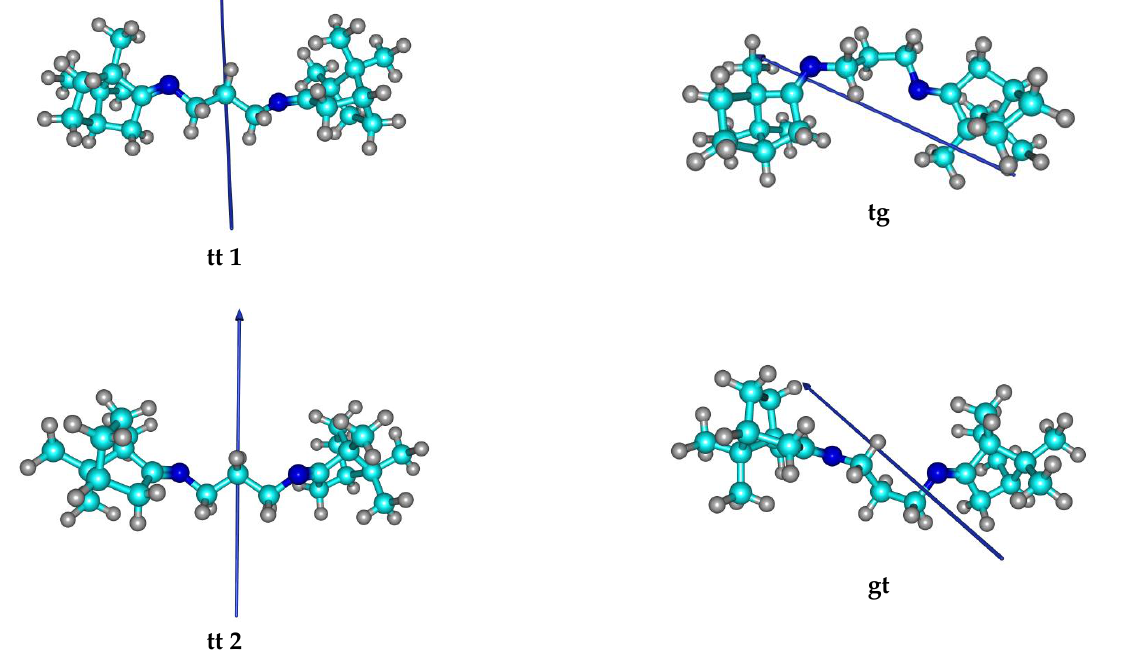
Figure 2. Structure of CPDA conformers and direction of dipole moments.